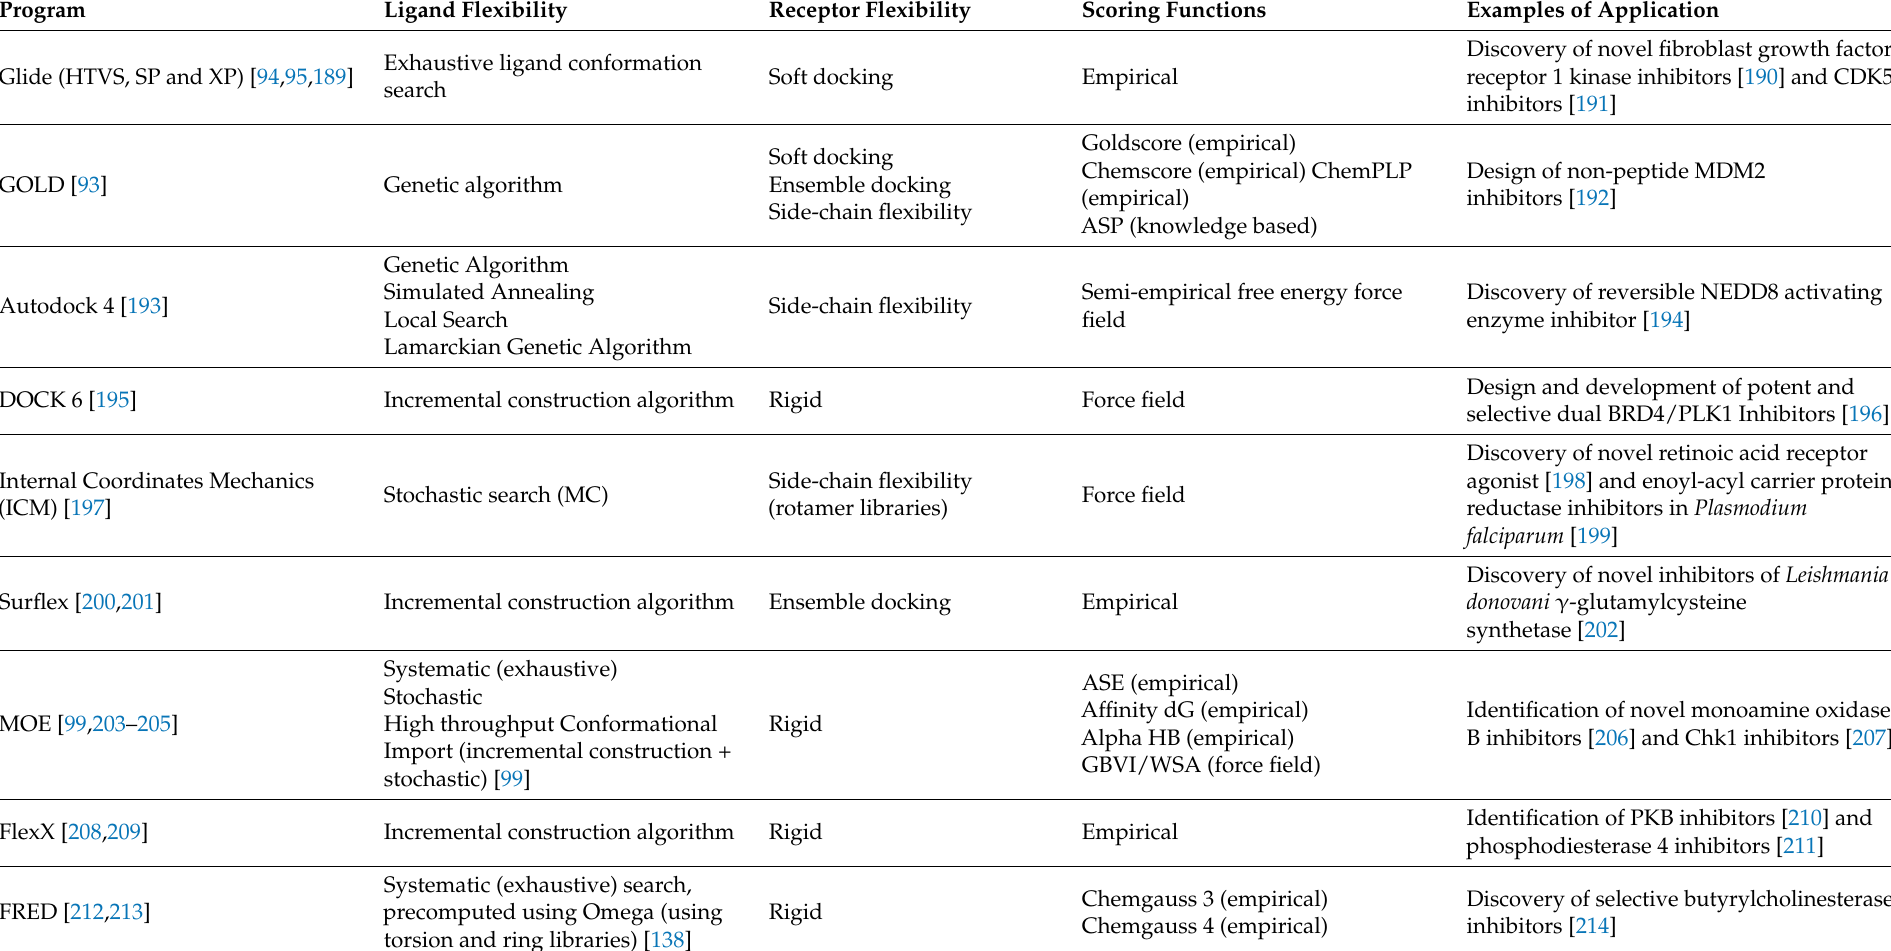
Table 1. List of common docking